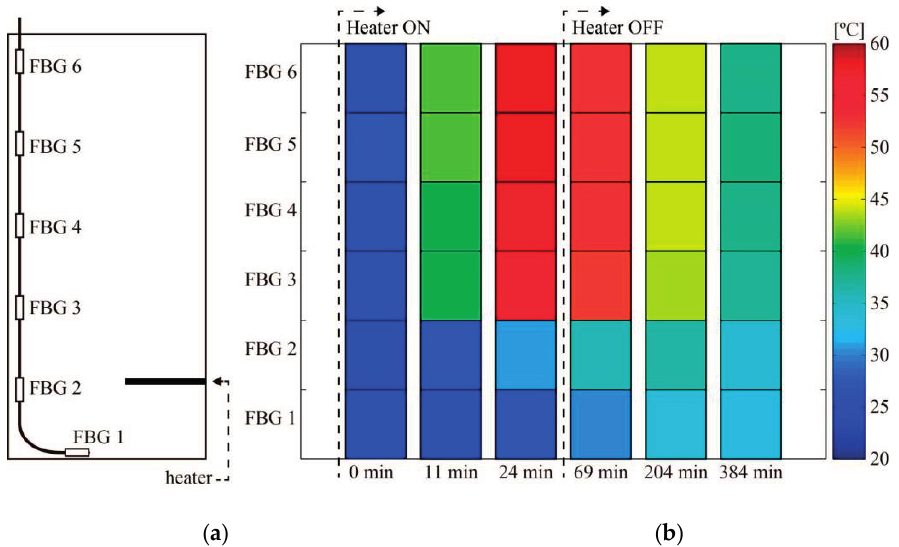
Figure 9. In-scale pilot representation of the oil tank. ( a ) Illustration of the fiber sensor immersed in the oil tank; ( b ) The quasi-distributed temperature